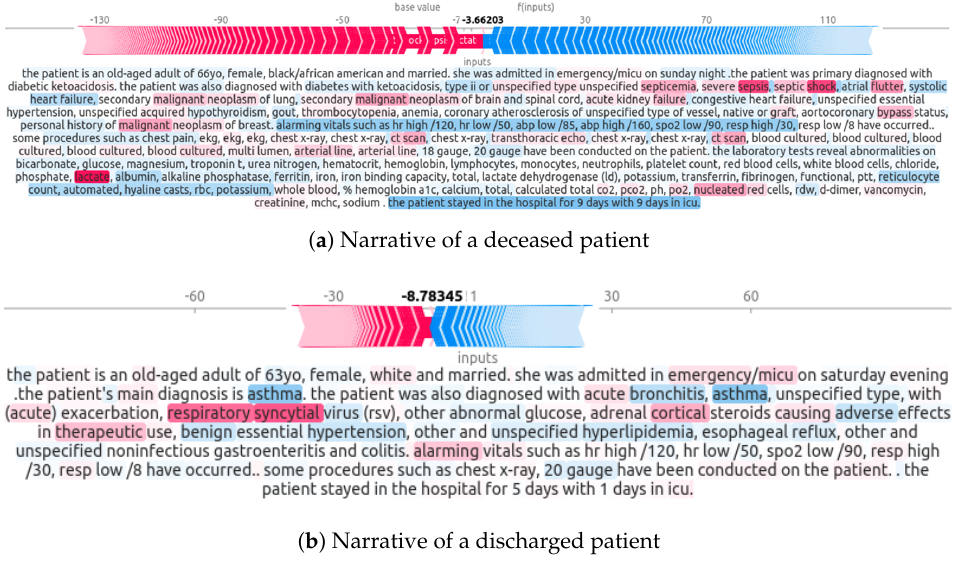
Figure 5. Interpretability visualization using shapley additive explanations (SHAP) on the narratives from two different